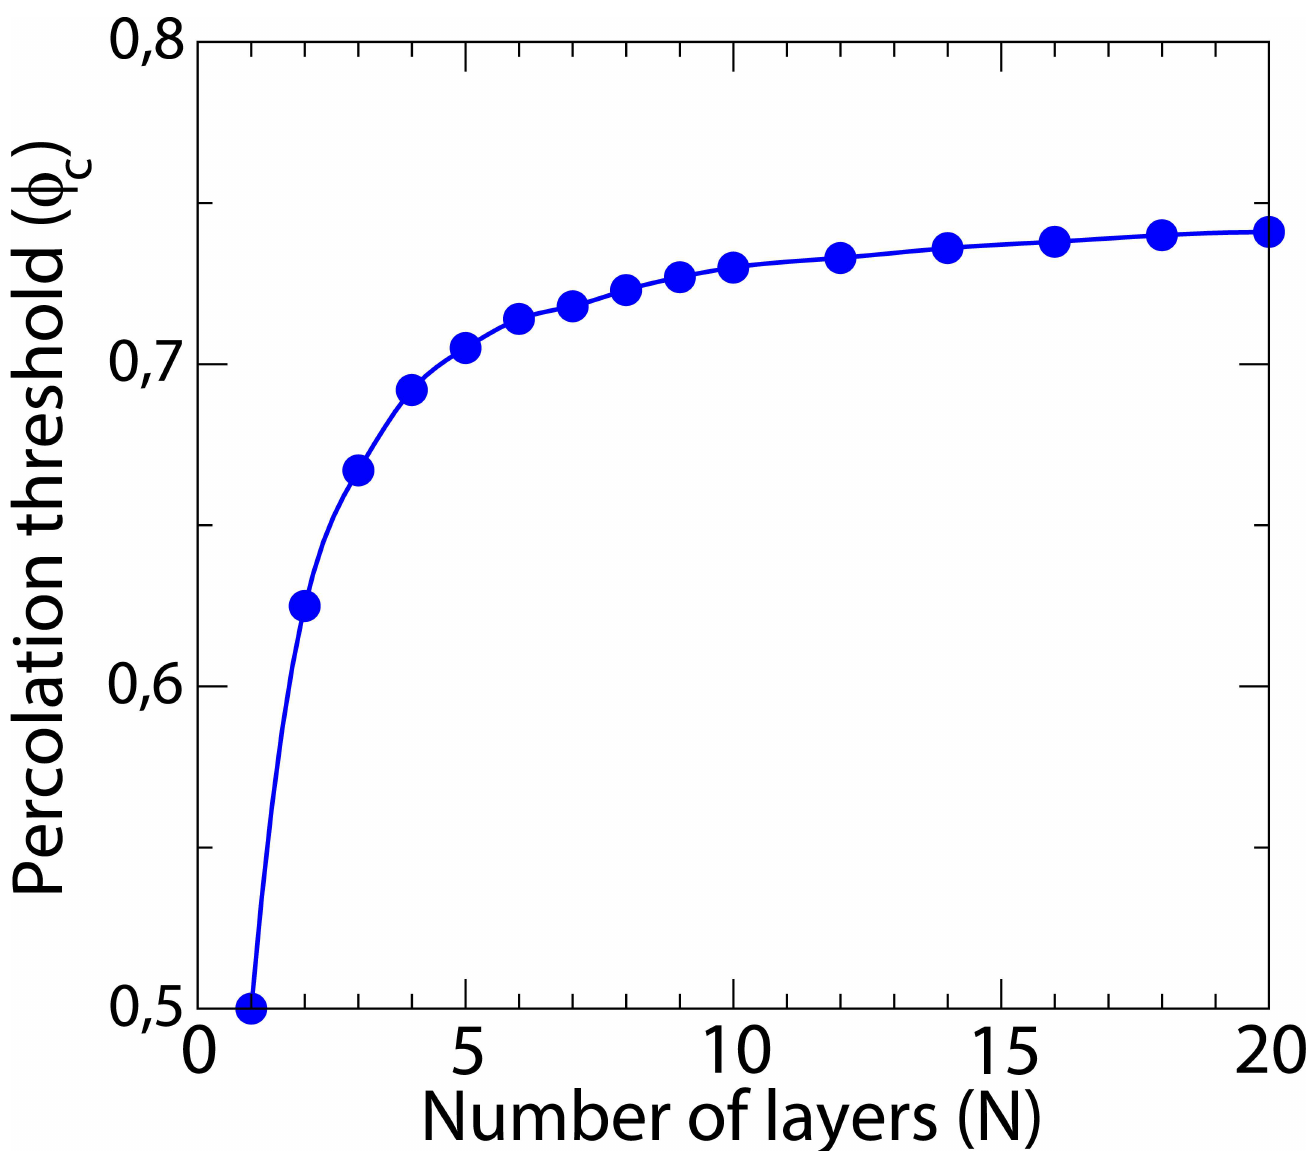
Fig 2. Percolation threshold for different slab thickness. Dependence of the percolationthreshold in a slab of tissue for different thickness. For each thickness N we generate100 realizations for each value of ϕ and check the probabilityof finding a pathway from one side of the system to the other. After a fitting process, we evaluatethe fraction ϕ c which correspond to a probabilityof 50%. The size of the system is 4 cm × 4 cm × N layers , where each layer corresponds to 0.01 cm